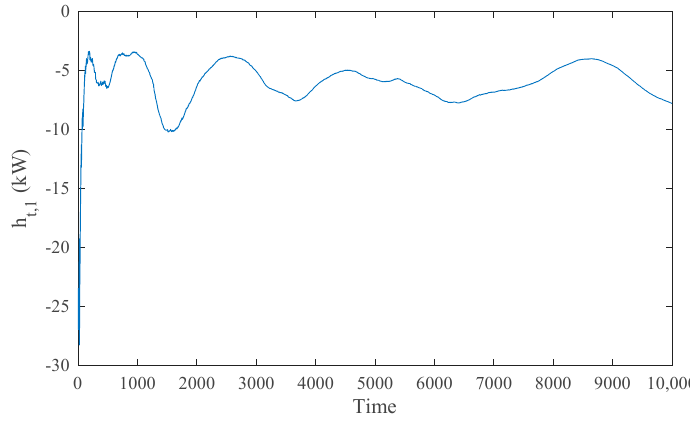
Figure 4. Tightening or relaxing parameter h t ,1